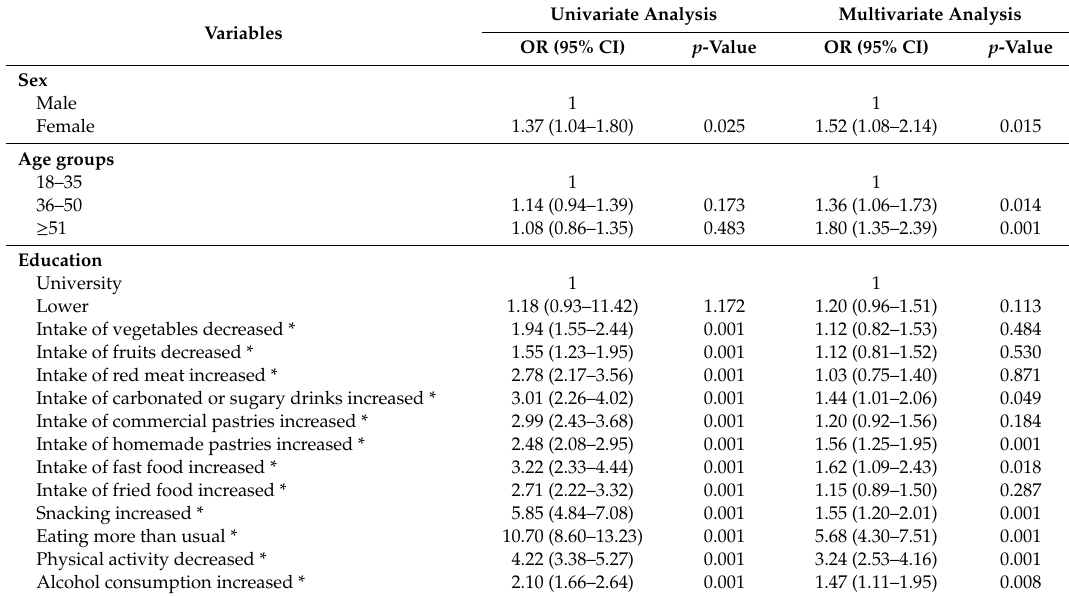
Table 4. Odds Ratios (OR) for the likelihood of weight gain by socio-demographic variables and changes in health behaviours during the quarantine.